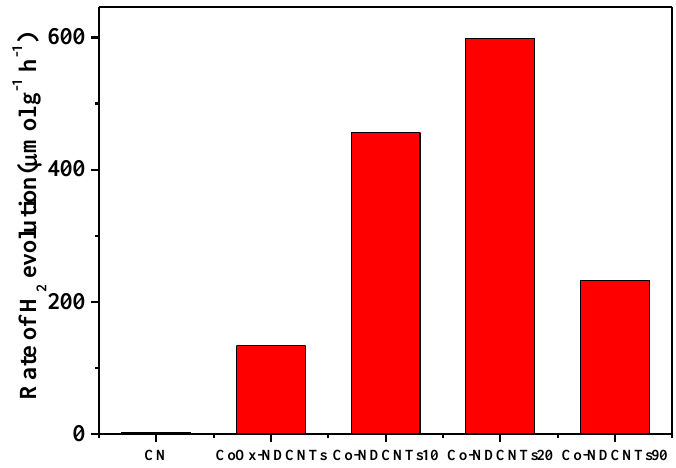
Figure 7. The calculation of the hydrogen generation rate of photocatalyst